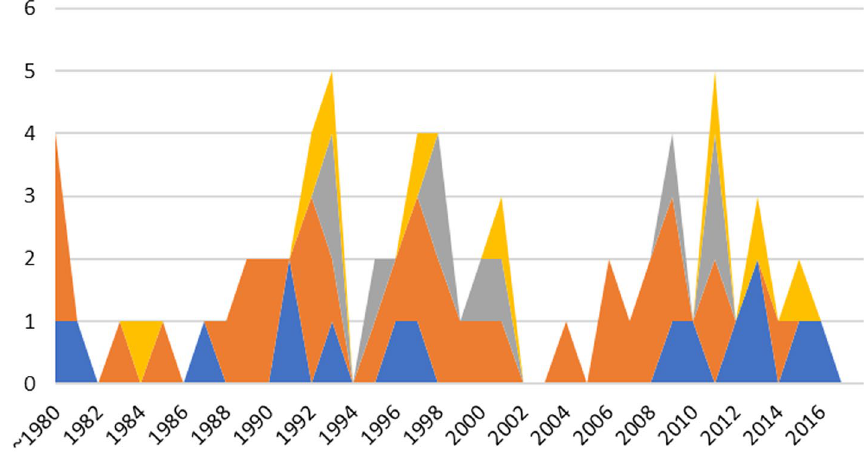
Fig. 1 Adoption of extraterritorial voting by regime type over time. Notes : Data from Wellman, Allen and Nyblade